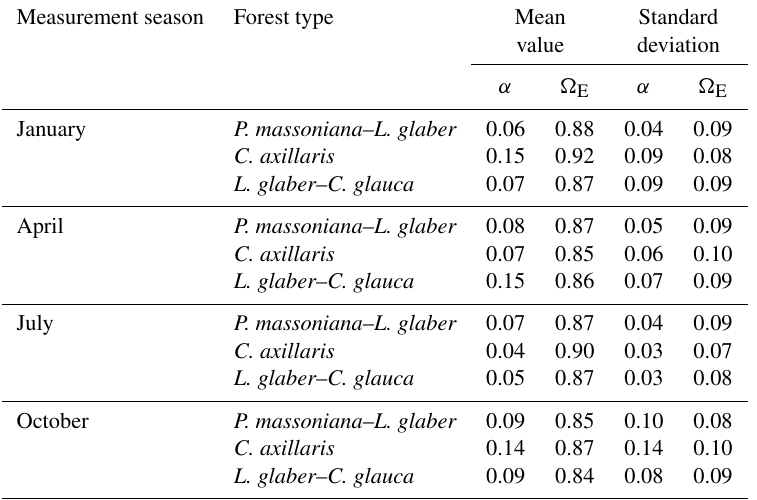
Table 2. Average woody to total leaf ration ( α) and clumping index ( (cid:127) E ) values in P . massoniana – L . glaber , C . axillaris , and L . glaber – C . glauca forests. Values in parenthesis are the standard deviation of α and (cid:127) E values ( n =